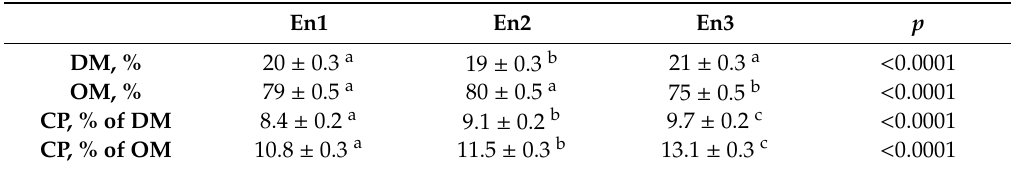
Table 6. Content of dry matter (DM), organic matter (OM), and crude protein (CP) as % of DM and as % of OM in feces from Gotlandsruss, divided equally between three enclosures (En1–En3) and grazing all year round.